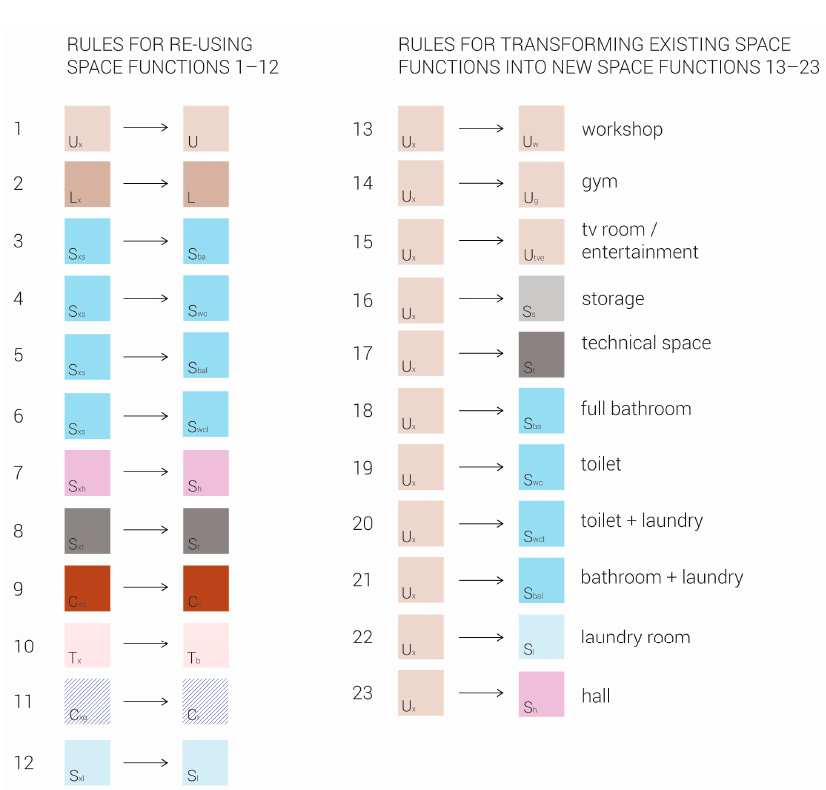
Figure 9. Existing floor plans with the classification of space functions (Ana Bel č i č , 2022).